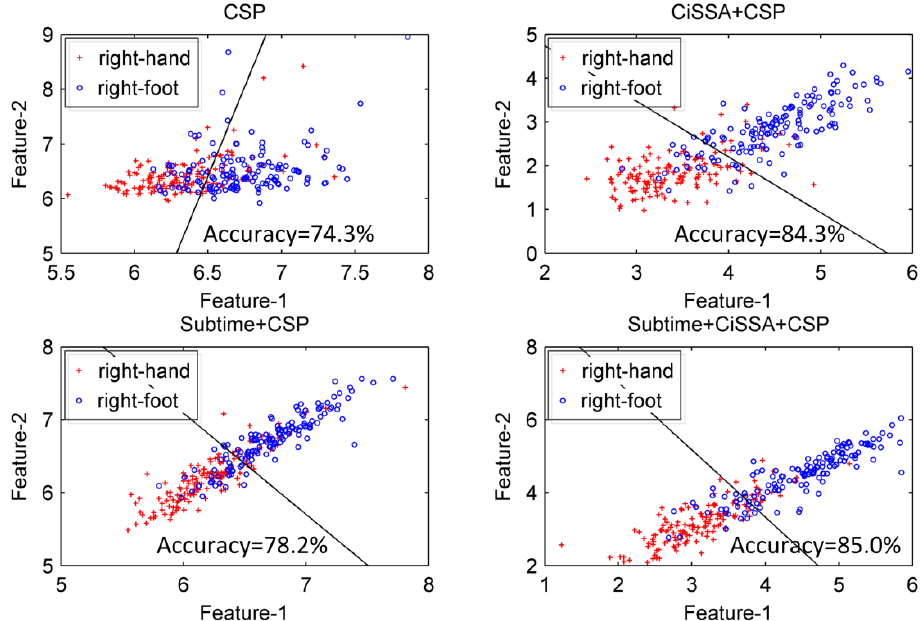
Figure 8. Distributions of the most two significant features obtained by CSP, CiSSA + CSP, Subtime + CSP and Subtime + CiSSA + CSP, for subjects aa.